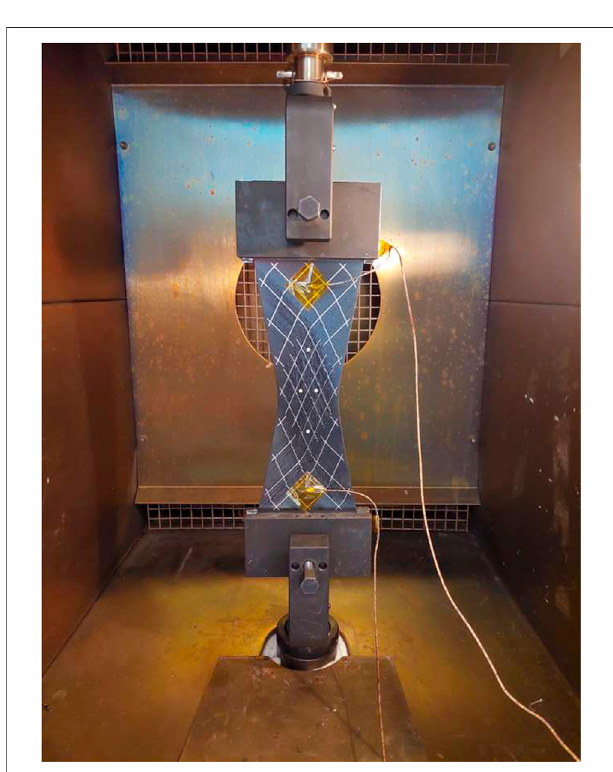
FIGURE 3 | Deformed specimen after testing, secured in the clamps with thermocouples attached.